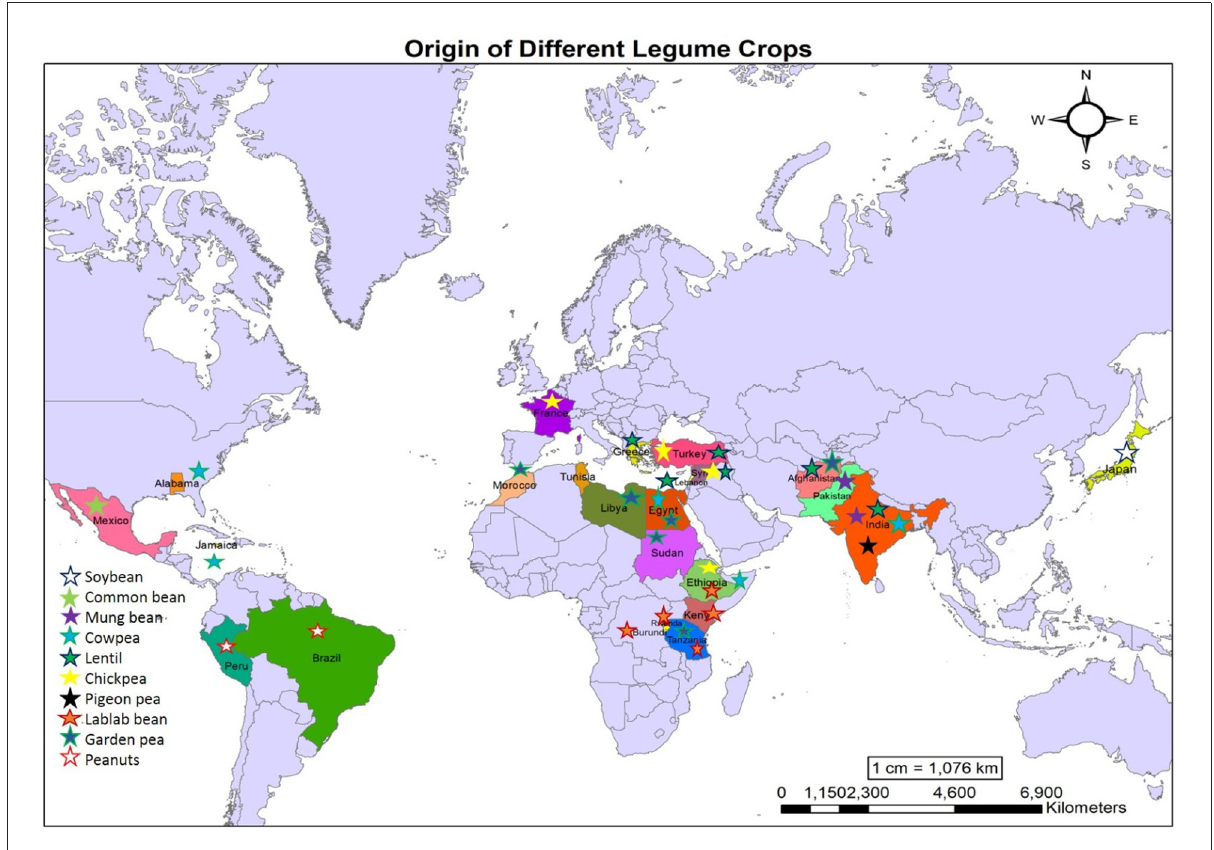
FIGURE1 Origin centers of various legume crops.